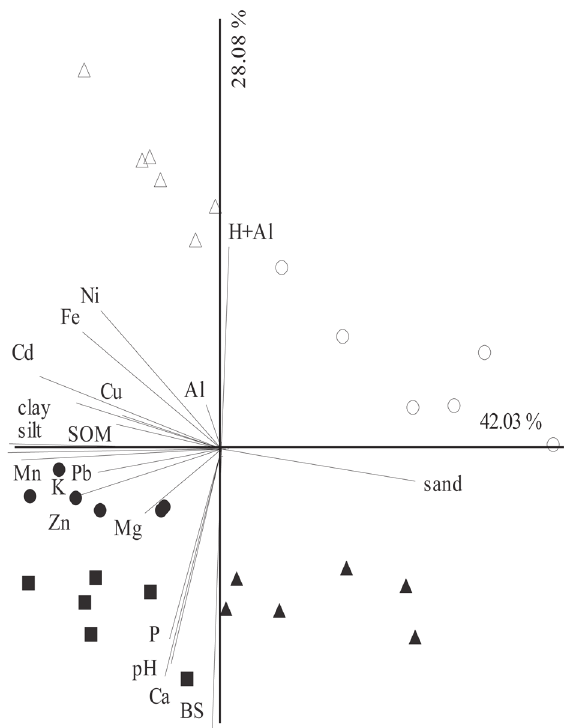
Figure 3. Principal component analysis (PCA) of physical and chemical attributes of soil under different land uses in the riparian zone around Extremoz Lake, northern Brazil. Potential acidity (H + Al); exchangeable aluminum (Al +3 ); available phosphorus (P); exchangeable sodium and potassium (K + and Na + ); exchangeable calcium and magnesium (Ca 2+ and Mg 2+ ); soil organic matter (SOM); and base saturation (BS). Natural vegetation (∆); pasture (Ο); agriculture ( ▲ ); urban ( ■ ); industrial land use ( ●